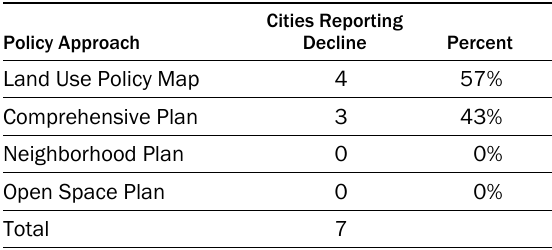
Table 3. Urban Agriculture Policy: Cities Reporting Table 4. Urban Agriculture Policy: Cities